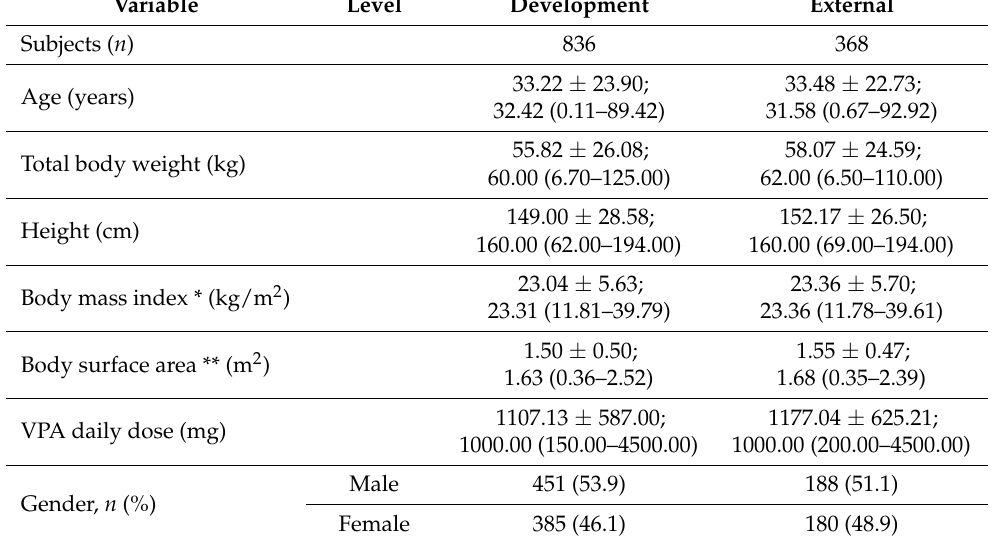
Table 1. Baseline patients’